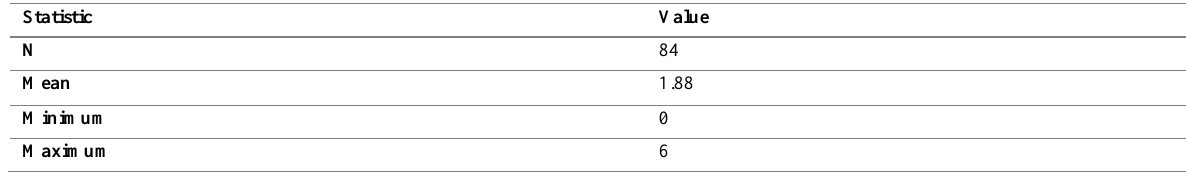
Table 4: Aggregate Economic Empowerment Statistics